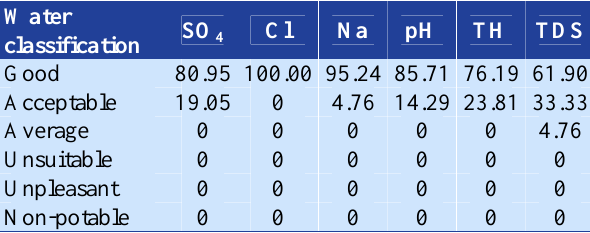
Table 3. Classification of water bodies based on Schuler